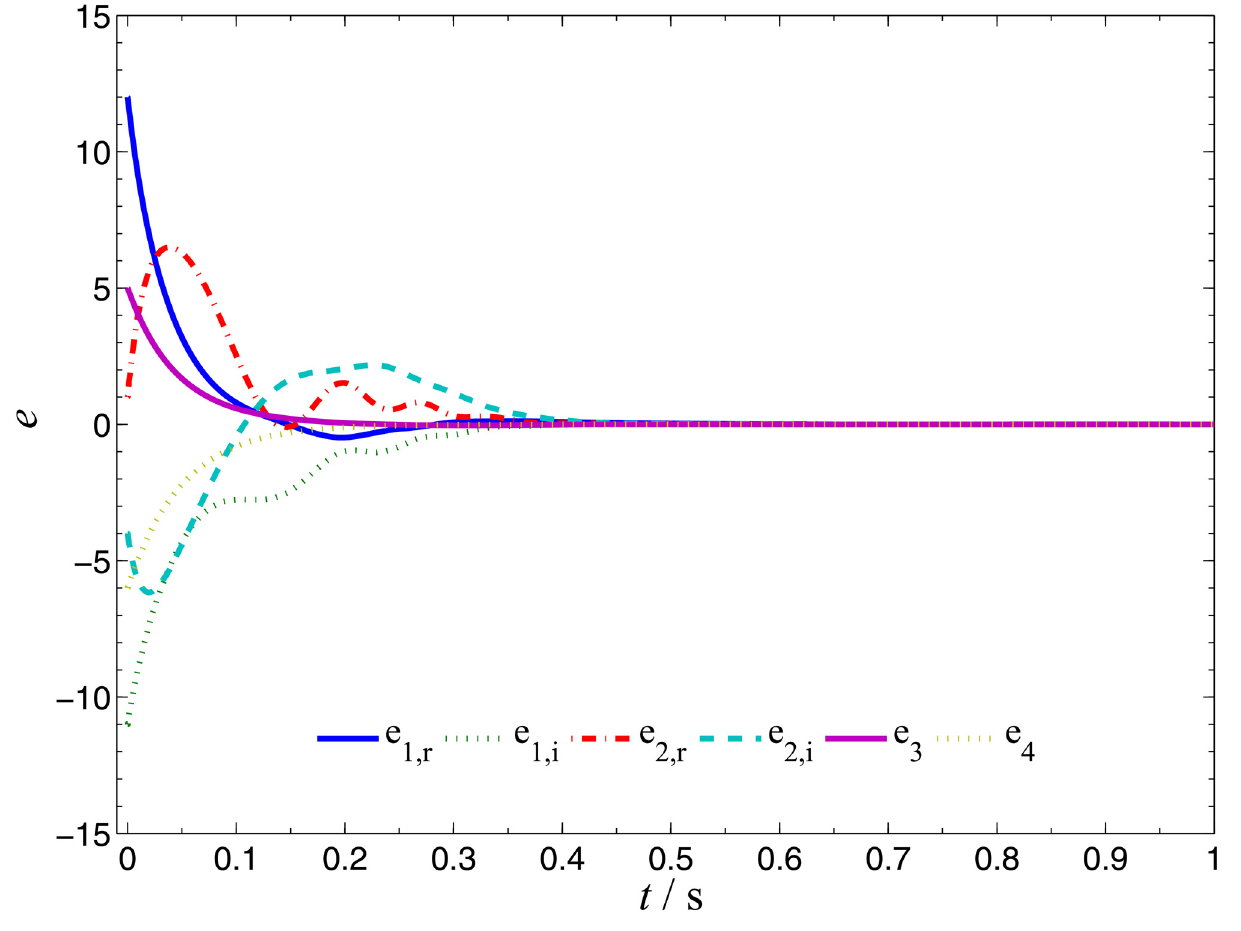
Fig 4. CGS errors of systems (12) and (13).